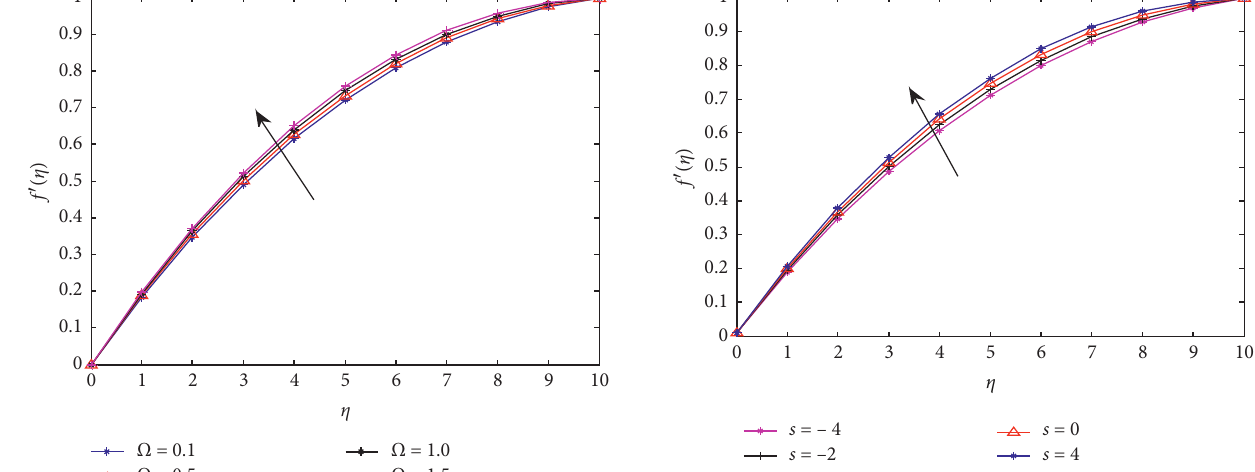
Figure 5: Velocity sketch for diverse values of s when Pr � 0 . 72, Ω � M � λ � R � 1, β � 0 . 2, c � 0 . 2, and Ec � 0 .